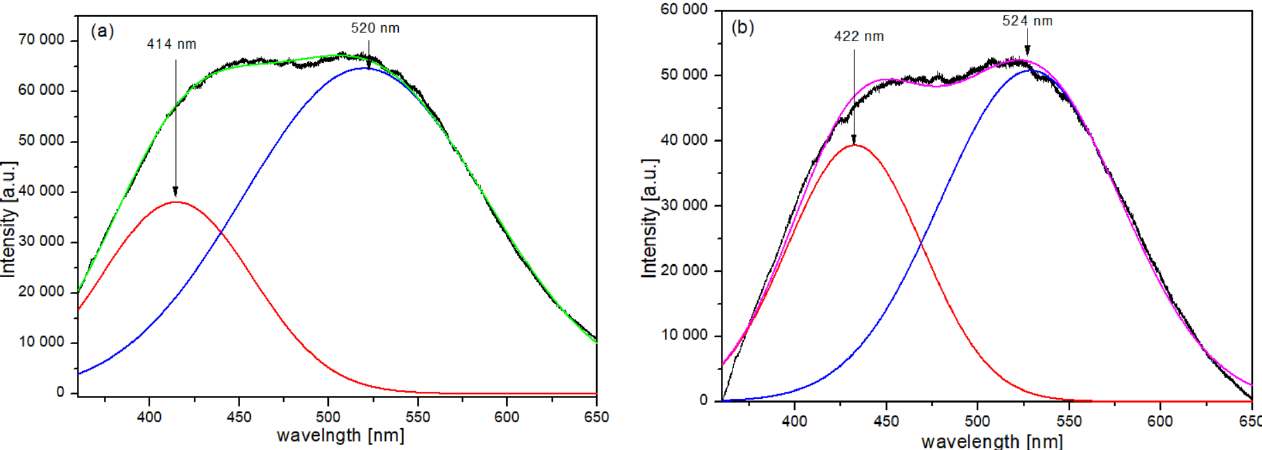
Figure 4. Florescence spectra (excitation 340 nm) of the HAs isolated from: ( a ) incubated samples of plant material, ( b ) forest soils.